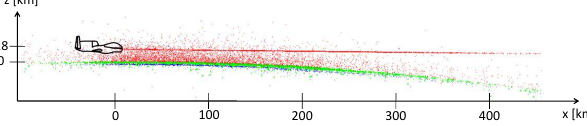
Figure 5. Three-dimensional simulation of the radiative transfer of the limb measurement at 18km altitude above a marine stratocumu- lus cloud deck located at 2km altitude with optical thickness of 30. Red, green and blue points mark each Rayleigh, Mie, and ground reflection scattering event,